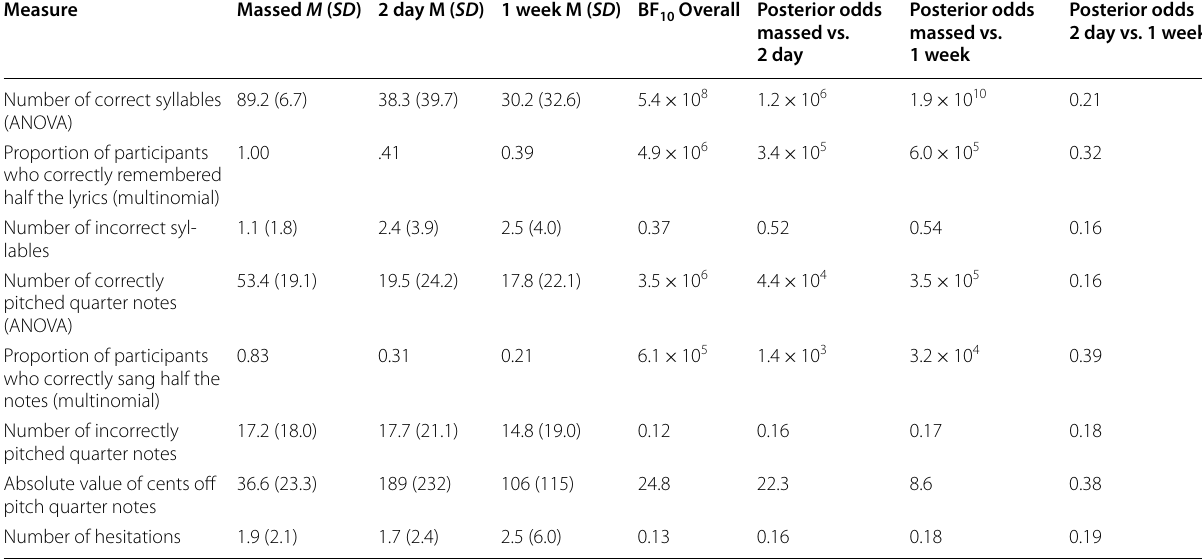
Table 1 Measures of forgetting at test